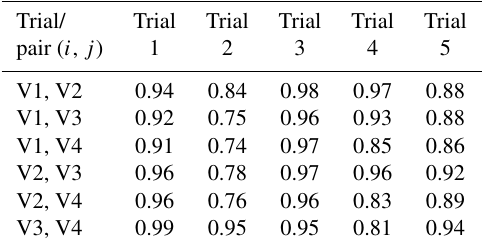
Table 6. Mean values of the imaginary part of the complex corre- lation coefficients over frequency for different antenna pairs. The first column indicates from which measurement trial the measured sample sequences of the specified antenna originate.